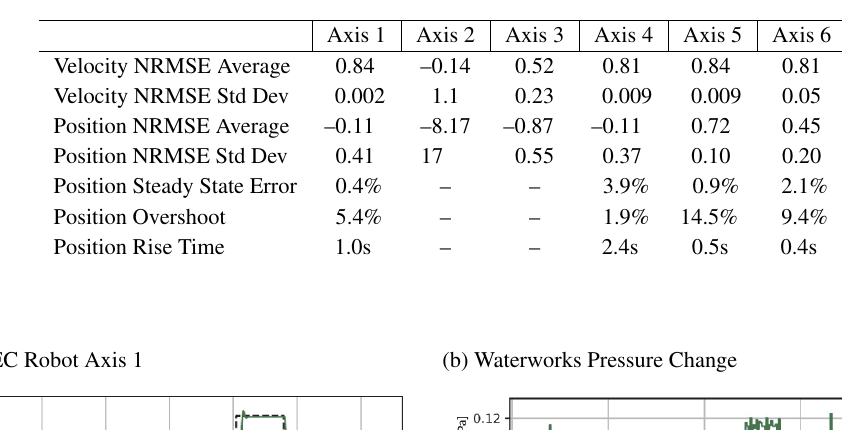
Table 1. AAvverage and standard deviation of NRMSE for robot axes velocity model and MPC performance indicators for robot axes position control